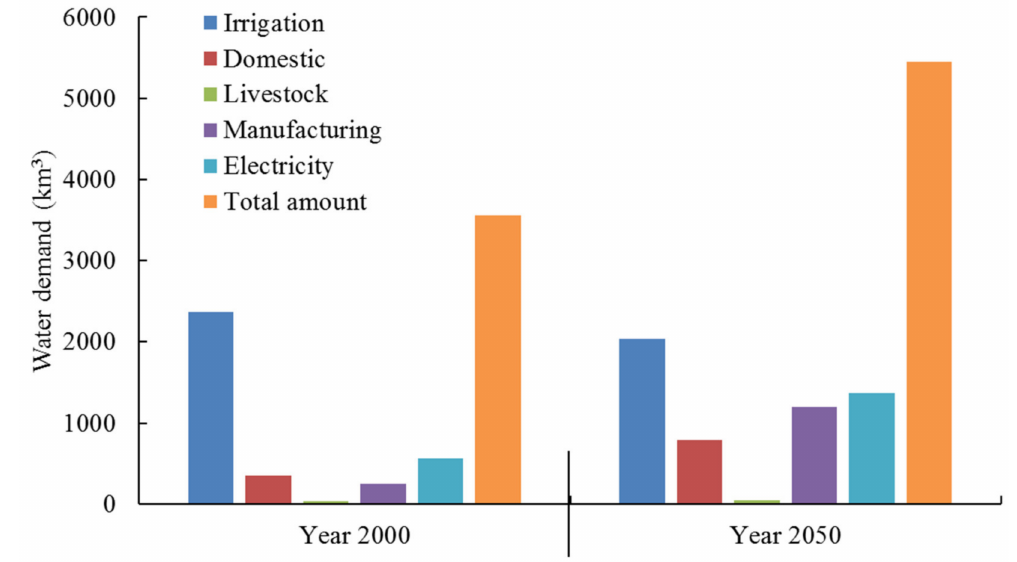
Figure 1. Global water demand (Baseline Scenario 2000 and